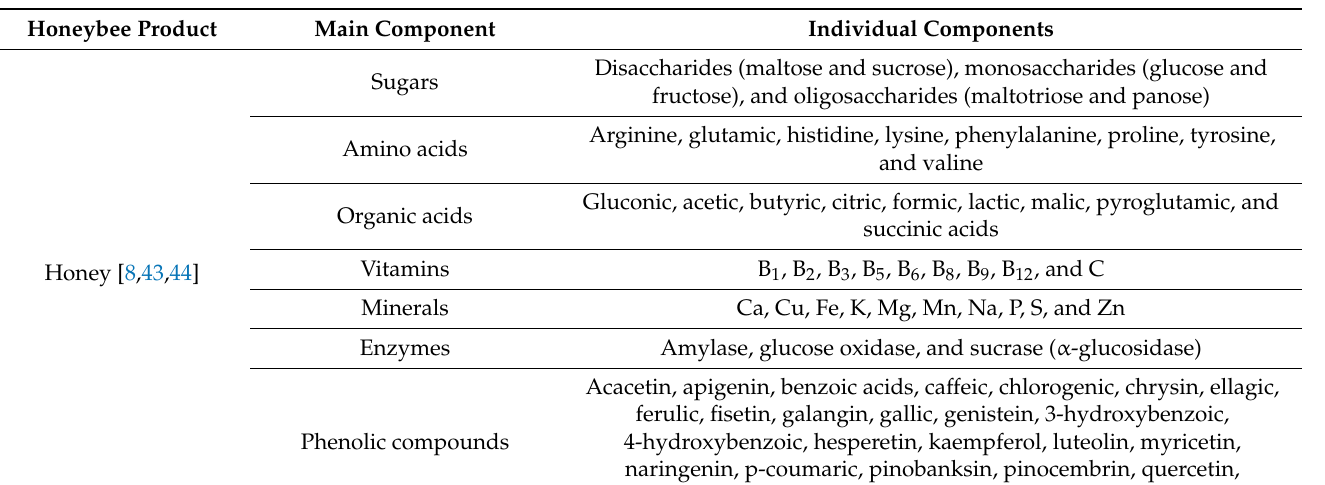
Table 2. Chemical composition of different honeybee products. Honeybee